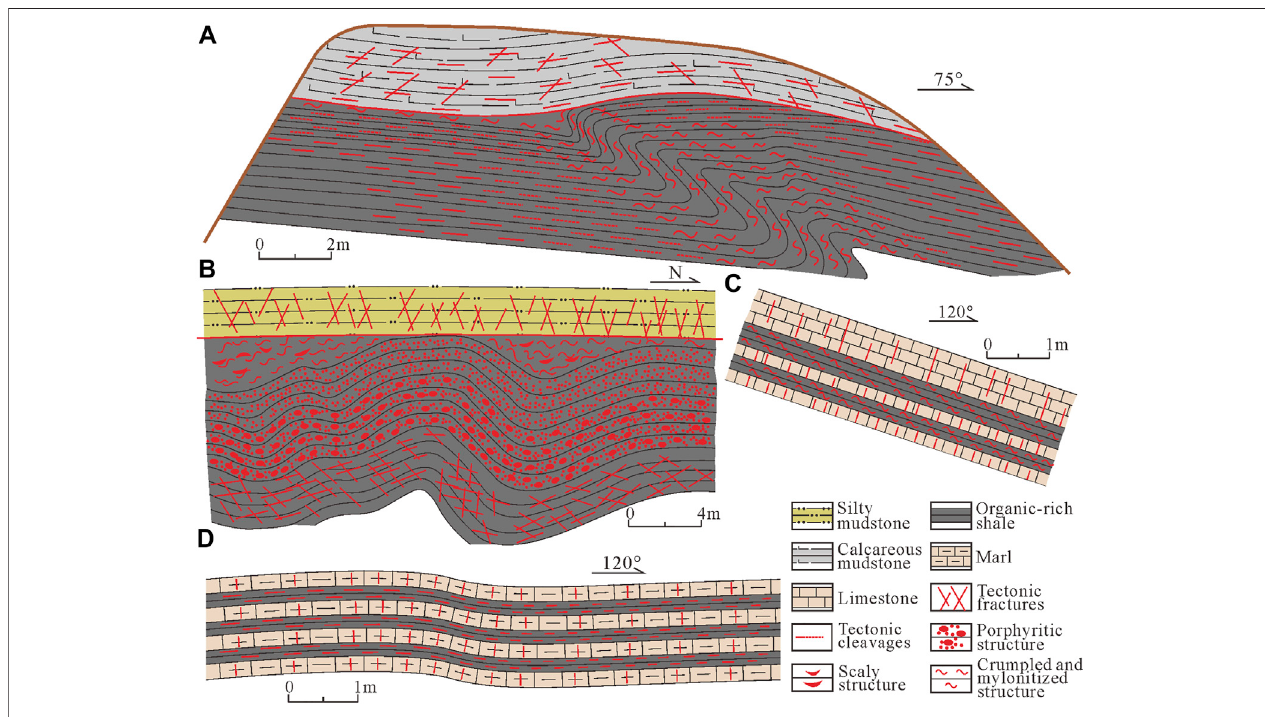
FIGURE 8 | Distribution schematic diagrams of shale deformation structures in fold structures. Notes: (A) chevron folds in observation point G1102; (B) folds in observation point G0811; (C) small bedding slip structures in observation point G0820; (D) a fl exure structure in observation point G0813.